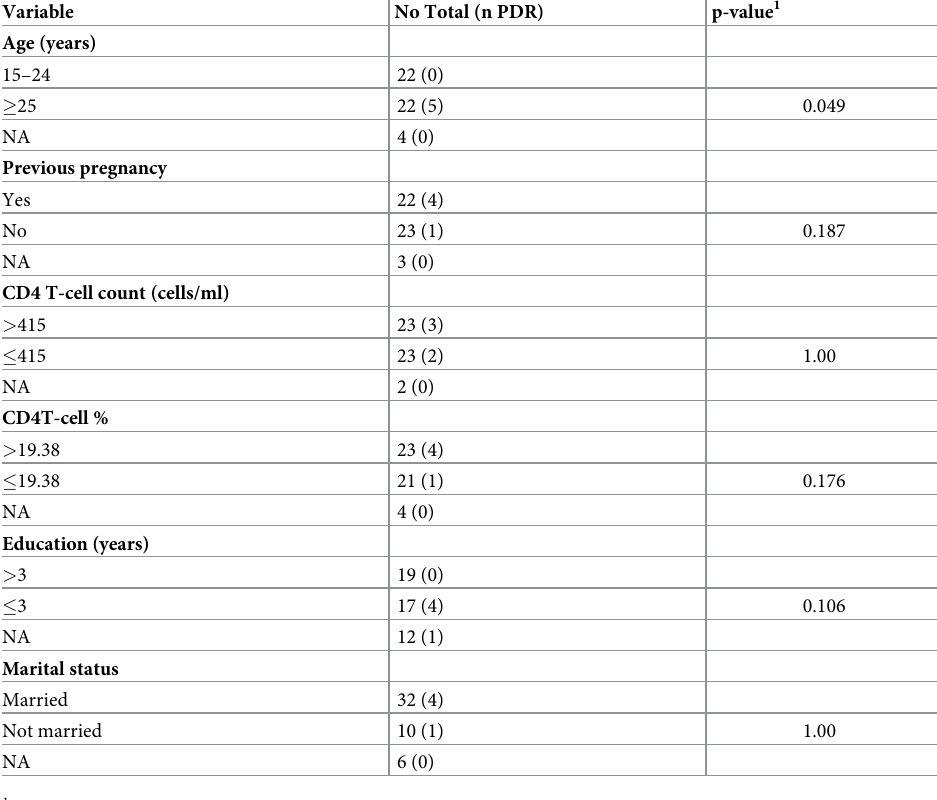
Table 3. Medical and socioeconomic data of study participants in relation to pretreatment drug resistance